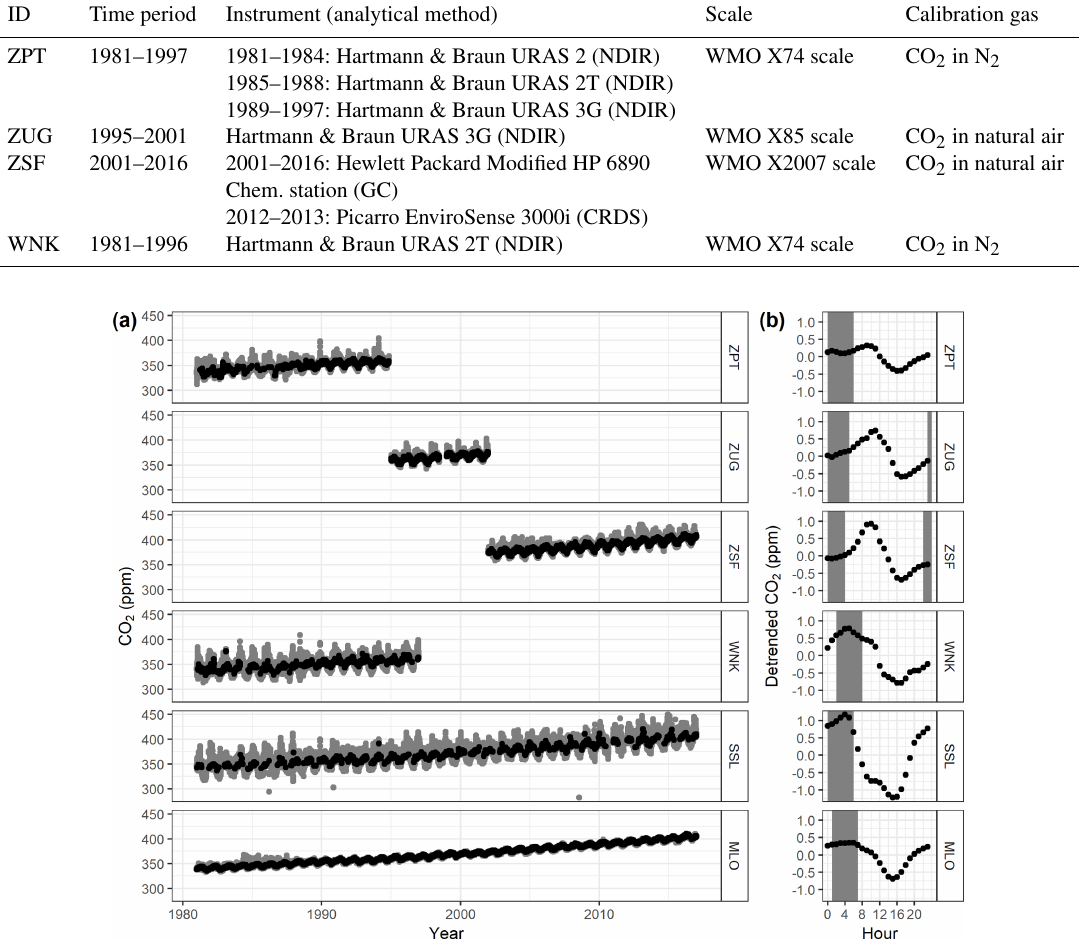
Figure 2. (a) Time series plot of 30-min averaged CO 2 concentrations measured at Mount Zugspitze (ZPT, ZUG, and ZSF) and Wank (WNK), and hourly averaged CO 2 concentrations measured at Schauinsland (SSL) and Mauna Loa (MLO) with ADVS selection. Grey and black colors are used for the unselected and selected results. (b) Detrended mean diurnal cycles with starting time windows (in grey) for ADVS data